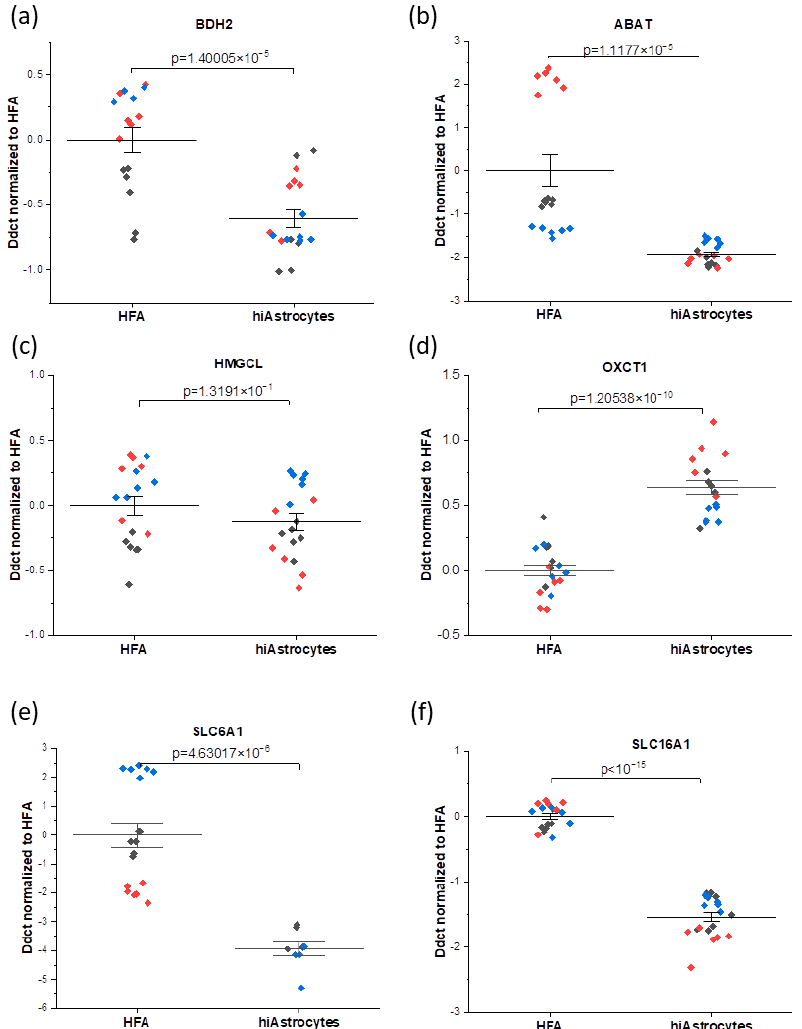
Figure 3. mRNA analysis profiles showing the comparison between the HFA and hiAstrocytes for the genes connected to metabolic enzymes ( a – d ): ( a ) BDH2 ( b ) ABAT, ( c ) HMGCL, ( d ) OXCT1, and transporters ( e , f ): ( e ) SLC6A1 ( f ) SLC16A1. (i.e., the data here are normalized to HFA control). The data were collected as technical duplicates, with distinct colors indicating different experimental rounds. Whiskers indicate ± SE around the bar that represents the mean. Genes of interest are normalized to the housekeeping gene GAPDH.